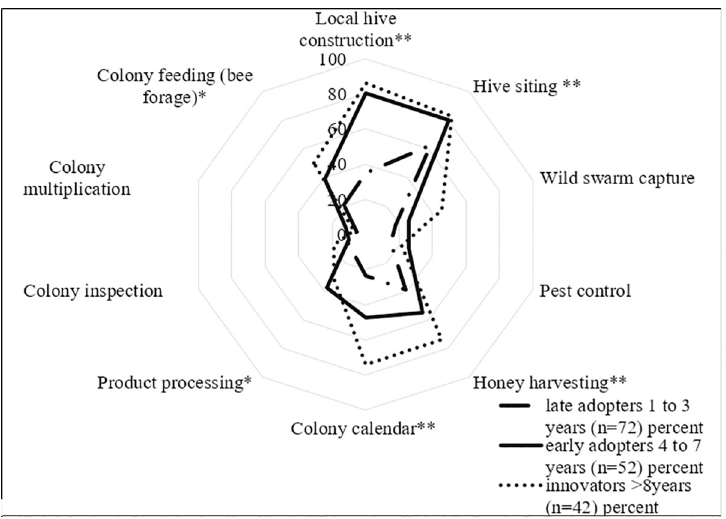
Fig 2. Beekeepers’ knowledge across adopter categories. Each line type represents an adopter category. Dotted line represents the level of beekeeping knowledge. The outer ring of the dotted web indicates the highest level of knowledge, whilst the most inner ring indicates the lowest level of knowledge. Pearson’s chi-square test of distribution. Significance level = � 10% , �� at 5% and ��� at 1% indicate significant differences of knowledge types held.